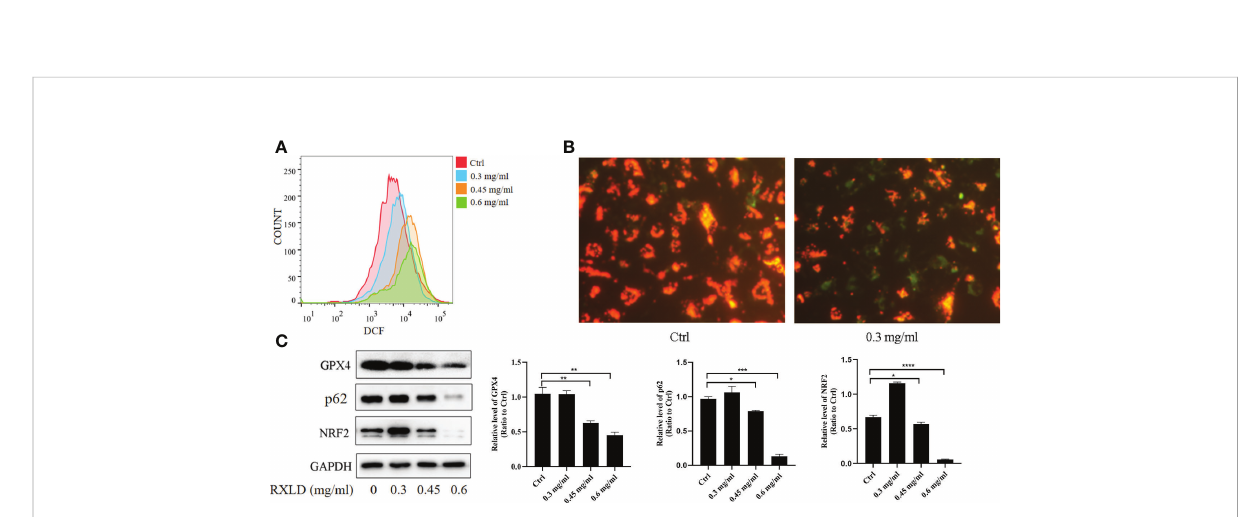
FIGURE 10 RXLD extracts regulated the oxidative stress and the ferroptosis process of GBM cells and inhibited p62/Nrf2 pathway. (A) The ROS assay was performed on A172 cells that were treated with RXLD extracts for 48 h; (B) The mitochondrial membrane potential assay was performed on A172 cells that were treated with RXLD extracts for 48 h; (C) Western blotting results of the p62 signaling pathway-related genes (GPX4, P62, and NRF2) in A172 cells treated with RXLD extracts (0.3, 0.45, and 0.6 mg/ml) for 48 h. * P<0.05, ** P<0.01, *** P< 0.001, ****